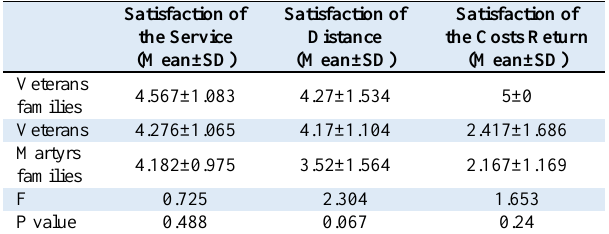
Table 2. Satisfaction of supplementary insurance in travel medical